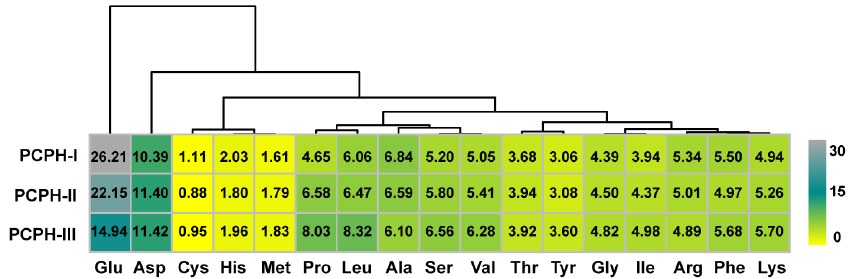
Figure 3. Heatmap with cluster by different amino acids of PCPHs based on amino acids contents (%). 2.1.3. Antioxidant Capacity of gel Chromatography Fractions from PCPH-III